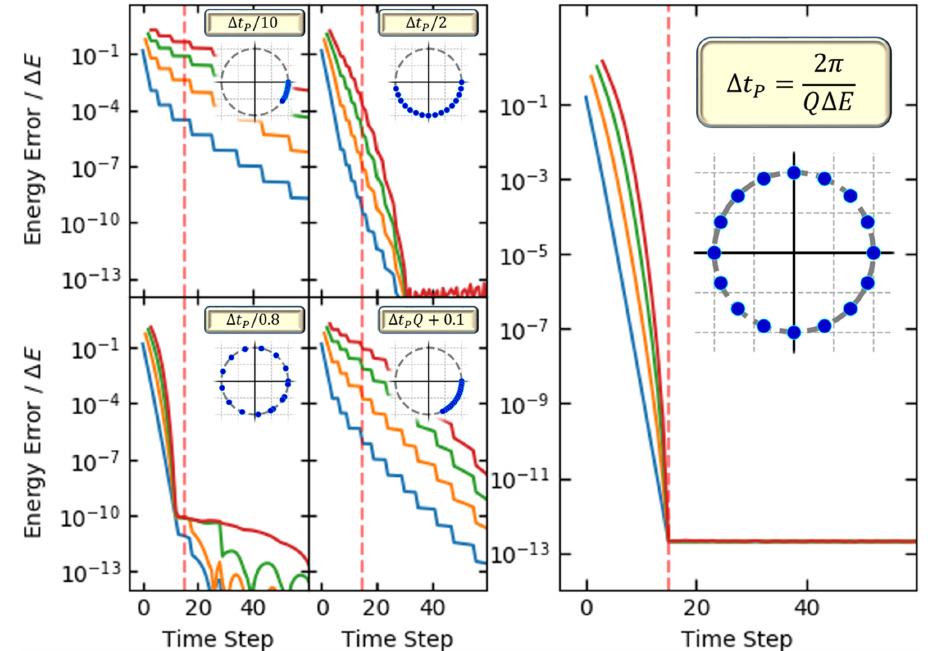
FIG. 1. Relative error of the first four eigenvalues from the real-time NOVQE secular equation for a Hamiltonian of linear spectrum E N = N (cid:10) E ( (cid:10) E = 0.75 here) and different time steps (cid:10) t as a function of the number of time steps. The reference state follows | (cid:4) 0 (cid:3) ∝ (cid:11) e − E N | N (cid:3) , such that only the 16 Hamiltonian eigenstates of lowest energy are part of the support space, choosing a coefficient N threshold of 10 − 12 . When solving the secular equation, we choose the same threshold for the SVD decomposition of the overlap matrix. The vertical dashed line marks the 15th time step, after which we have as many expansion states as vectors in the support space. The large subplot corresponds to the smallest time step that fulfills the phase cancelation condition, Eq. (10), which reduces to a single condition for this Hamiltonian. The insets in each subfigure correspond to a geometric representation of the phase cancelation condition, with each phase e − it j (cid:10) E a point in the unit circle on the complex plane. See the text for details.